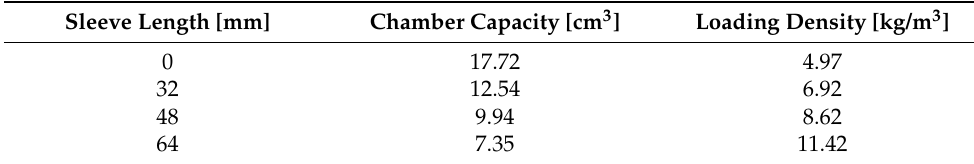
Table 1. Values of the chamber capacity and the loading